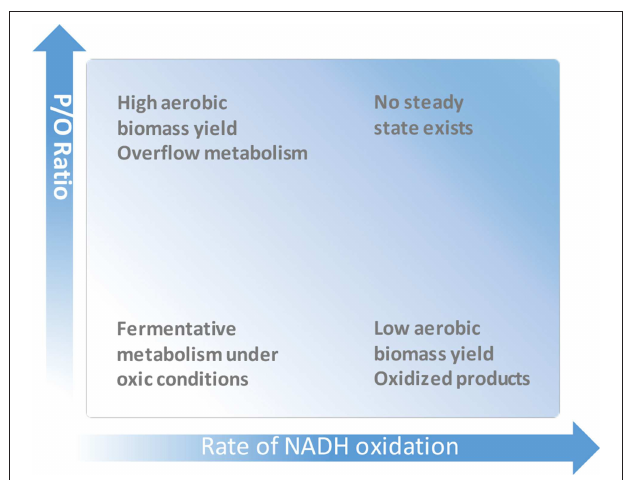
FIGURE 1 | Dependence of microbial growth and production on the energetical efficiency of